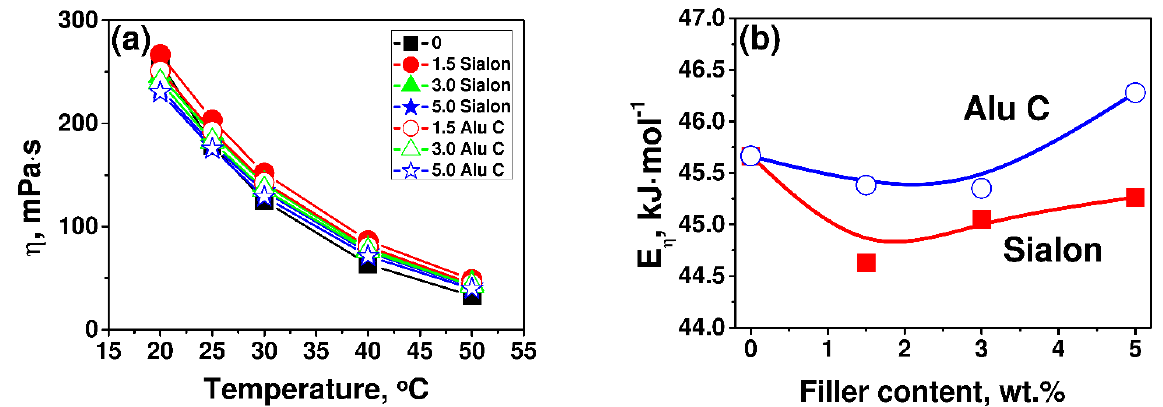
Figure 4. The ( a ) viscosity of the formulation at a shear rate ~100 rpm as the function of the temperature and ( b ) the dependency between the viscosity activation energy E η as the Sialon and Alu C content function. The numbers indicate the filler content as weight percent. The lines are guides for the eye.